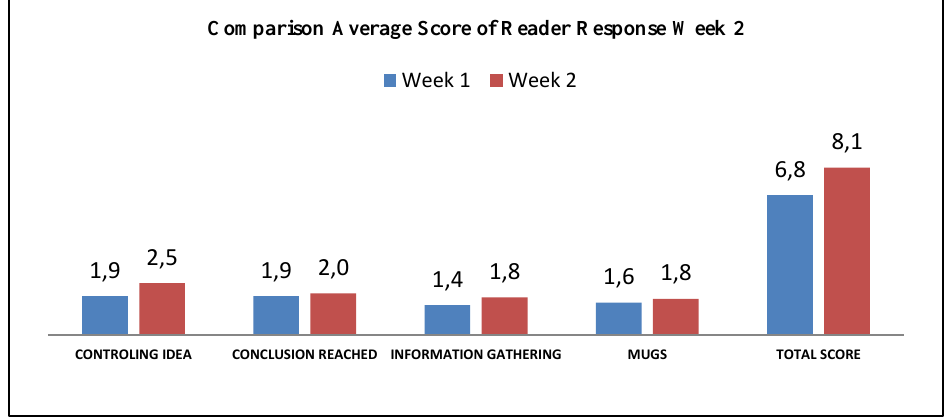
Chart 2: Average score of reader response week 1 and week